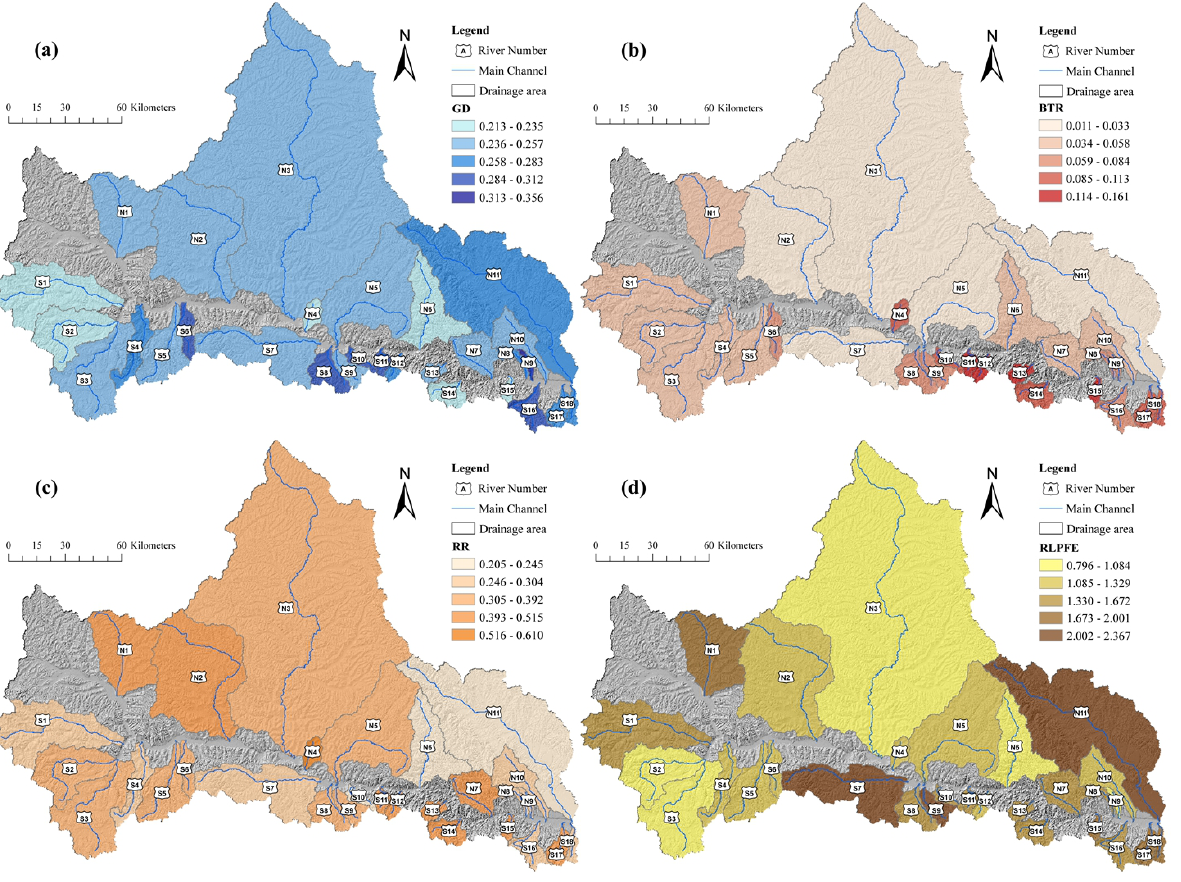
Figure 3. Distribution map of the upper reaches of the Weihe River